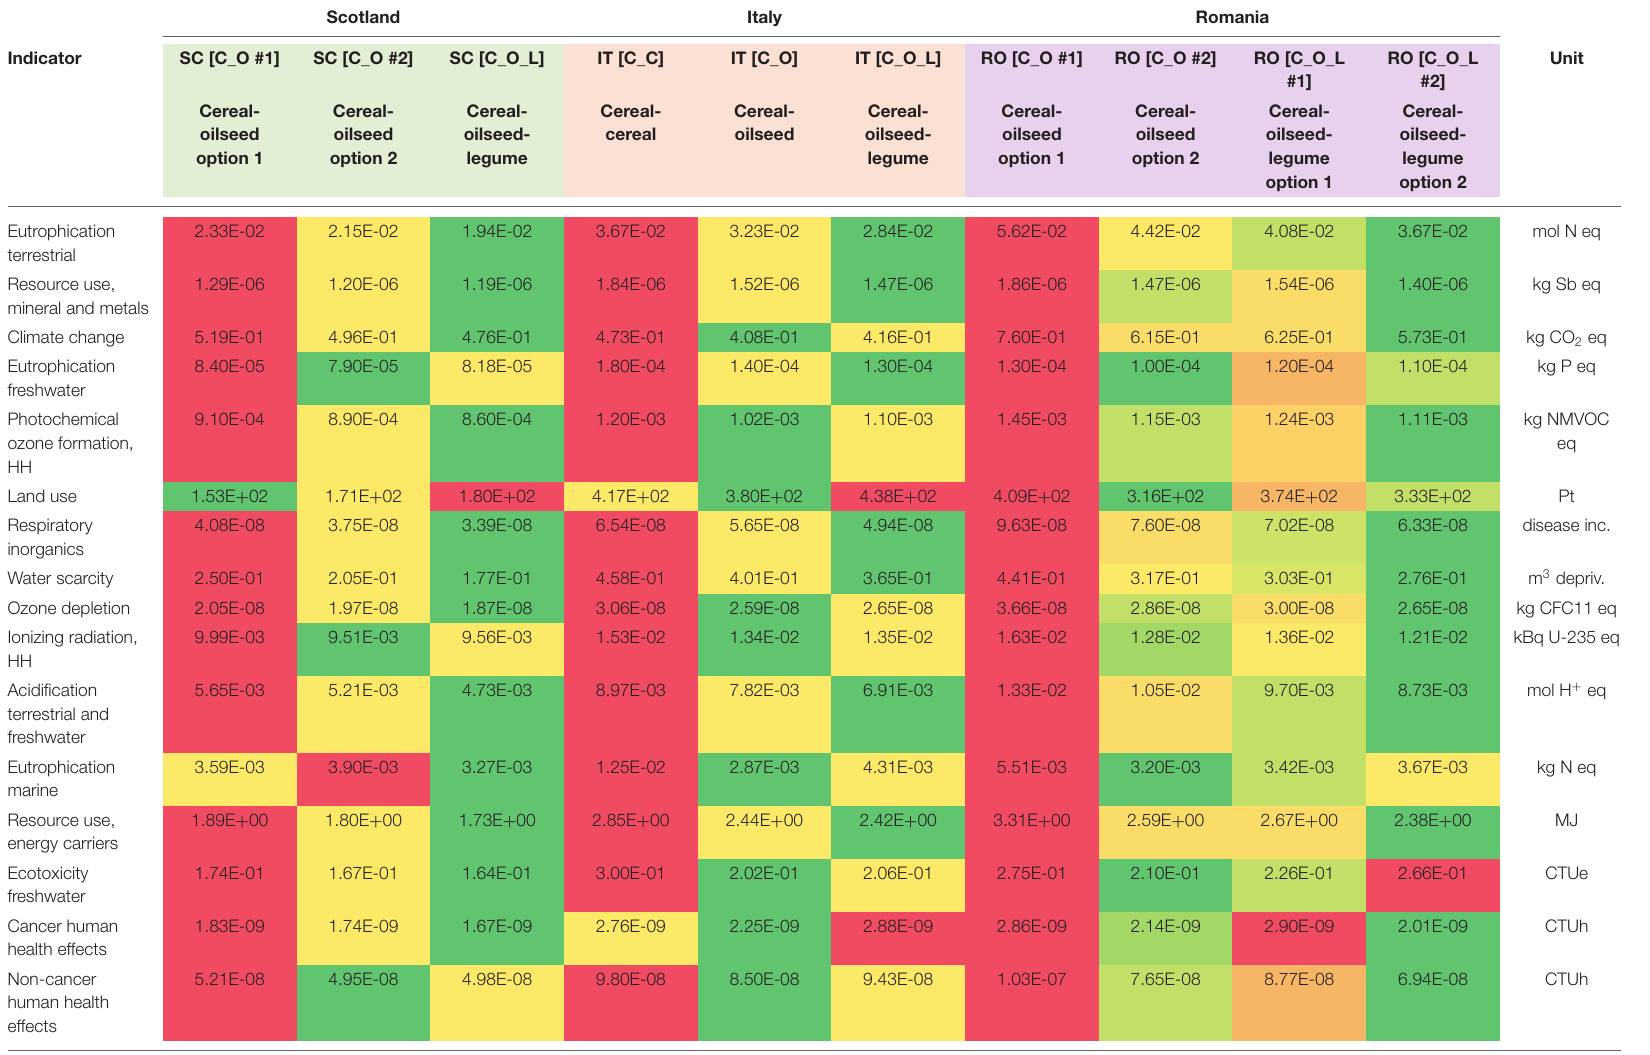
For each impact category and each region, the result for the rotation configuration with the highest impact is shaded darker red and the result for the rotation with the lowest impact is shaded darker